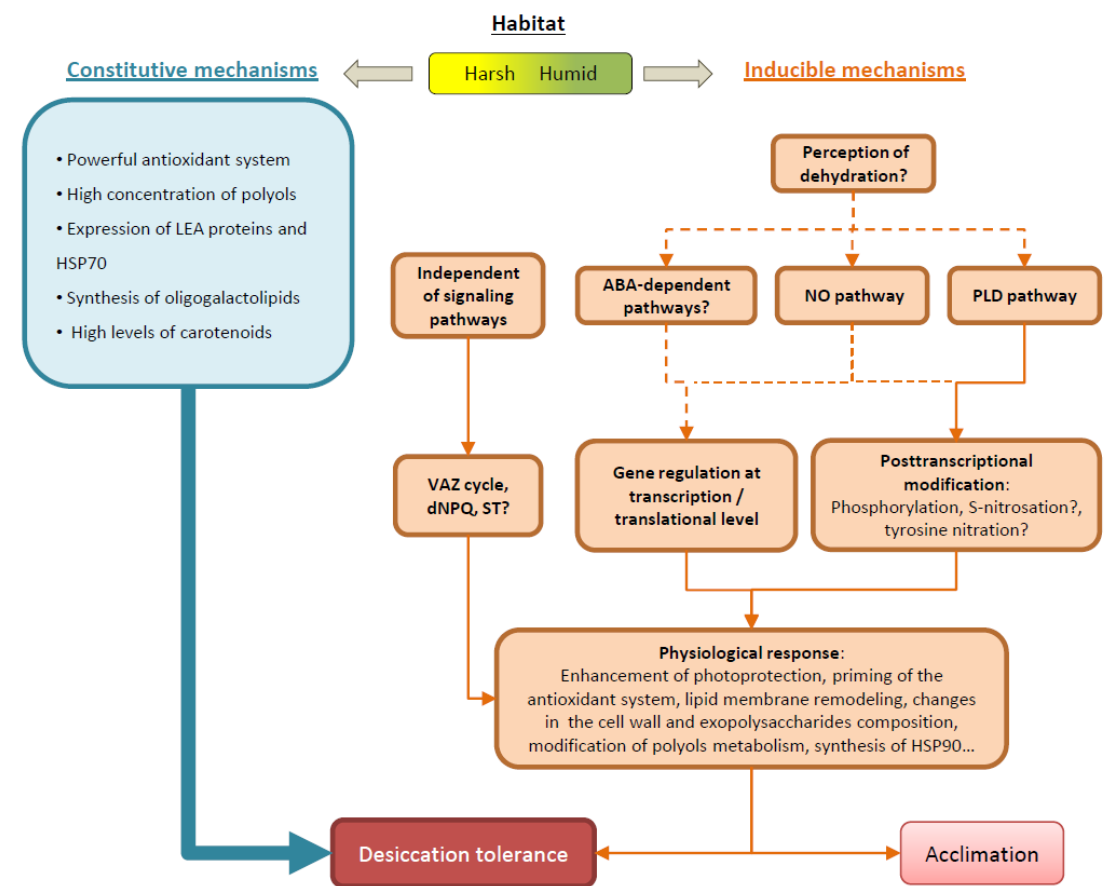
Figure 1. Lichen desiccation-tolerance (DT) is mainly achieved by constitutive mechanisms, although some physiological responses can also be induced during dehydration/rehydration. The relevance of constitutive and induced mechanisms may depend on adaption to habitat. In lichens growing in harsh habitats, DT relays mainly on constitutive mechanisms, whereas, in humid habitats, where drying occurs more slowly, lichens have enough time to induce cellular responses. The detection of cell water loss might trigger molecular signal cascades, such as the abscisic acid (ABA), nitric oxide (NO) and phospholipase D (PLD) pathways. Signaling pathways might regulate the expression of genes by the induction/inhibition of their transcription, or by the selective sequestration of specific mRNA that would be translated into proteins during rehydration. In addition, the activity of enzymes might be regulated by modifications such as phosphorylation. Besides regulation by signaling pathways, there are some physiochemical events indirectly caused by dehydration that can acti- vate enzymatic reactions, such as the activation of the xanthophyll cycle (VAZ), the regulation of the photosynthetic state- transition (ST), or the activation of the desiccation non-photochemical quenching (dNPQ). The activation of these (and other) physiological responses would allow the cells to face a desiccation event in a better position, and to recover quickly upon rehydration. In this sense, priming of physiological responses could help lichens to acclimate to environmental con- ditions. For more detailed information see the text. Solid arrows depict known pathways, while dashed arrows indicate proposed or unknown pathways.